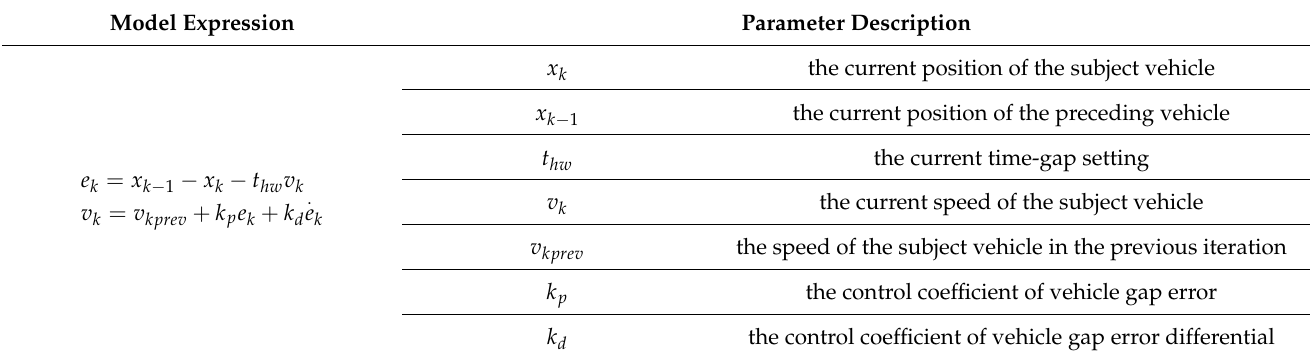
Table A1. PATH’s CACC car-following